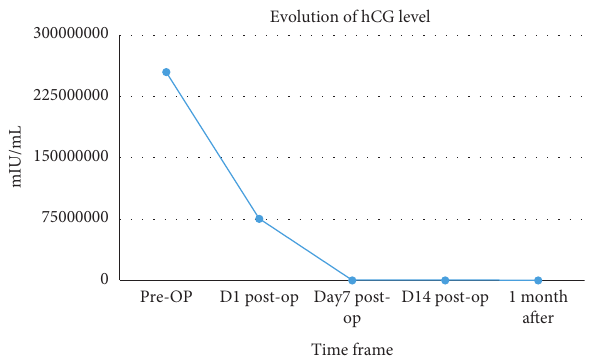
Figure 4: Evolution of beta-hCG level over the course of